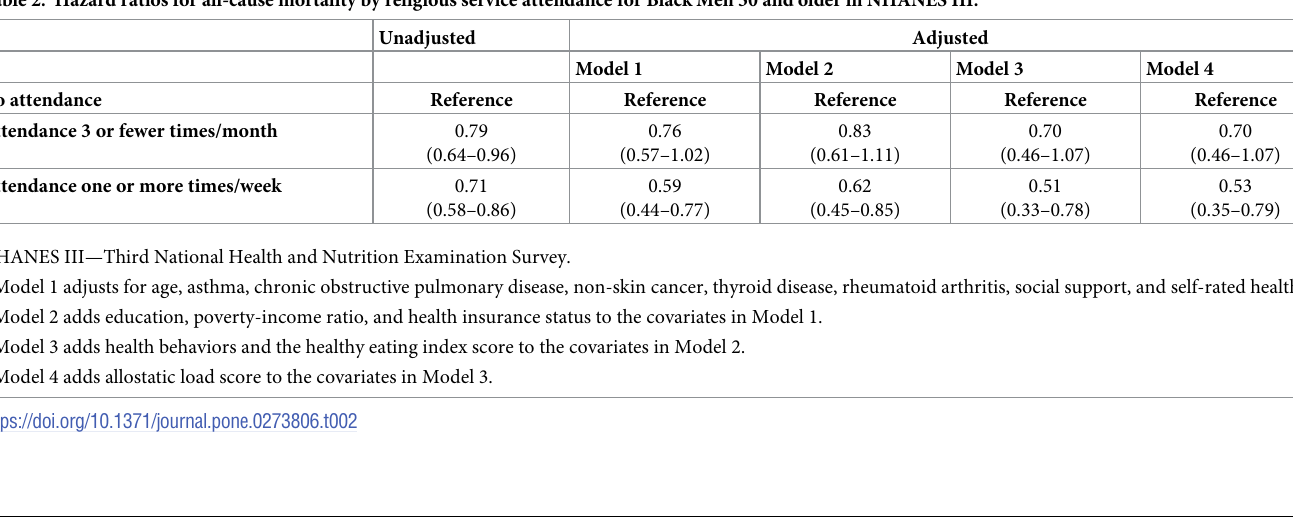
men is displayed in Fig 2 and Table 2. The unadjusted Kaplan-Meier curves presented in Fig 2 indicate that survival was highest among Black men who attended religious services at least weekly and lowest among those who did not attend at all. Black men who attended religious